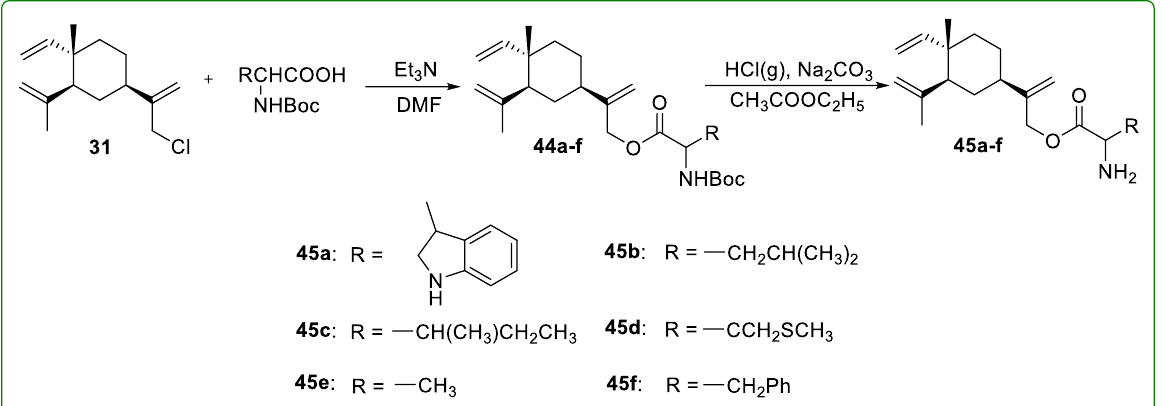
Figure 14. Chemical structures of β -elemene ester derivatives 45a – f.